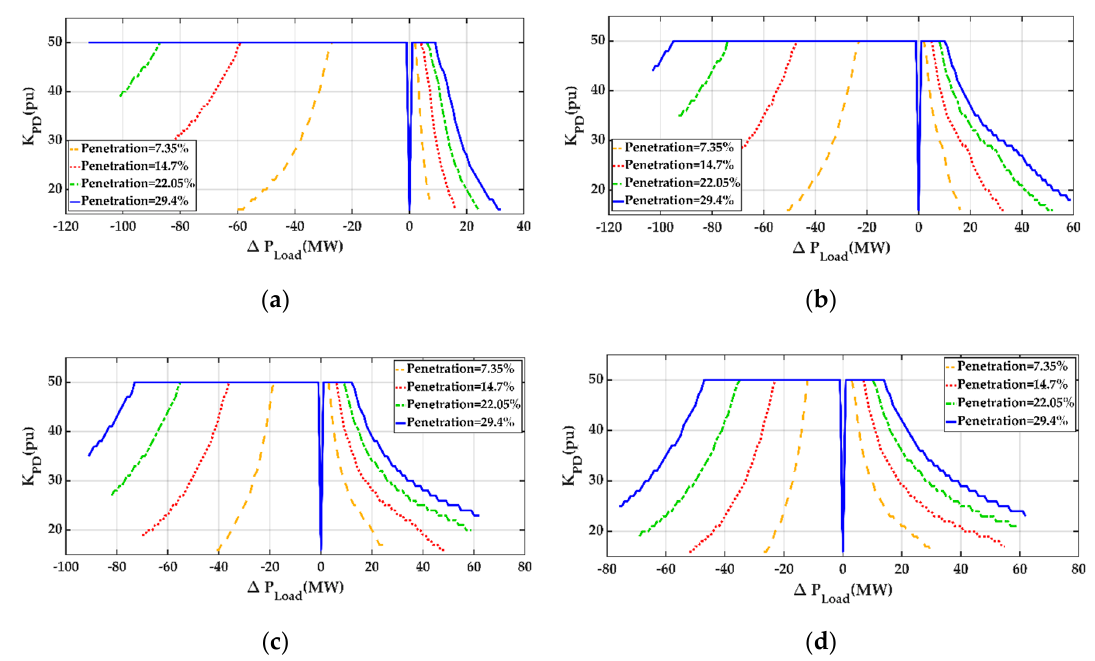
Figure 9. Training patterns under four different wind speeds: ( a ) V W = 9 m/s, ( b ) V W = 10 m/s, ( c ) V W = 11 m/s, and ( d ) V W = 12 m/s.